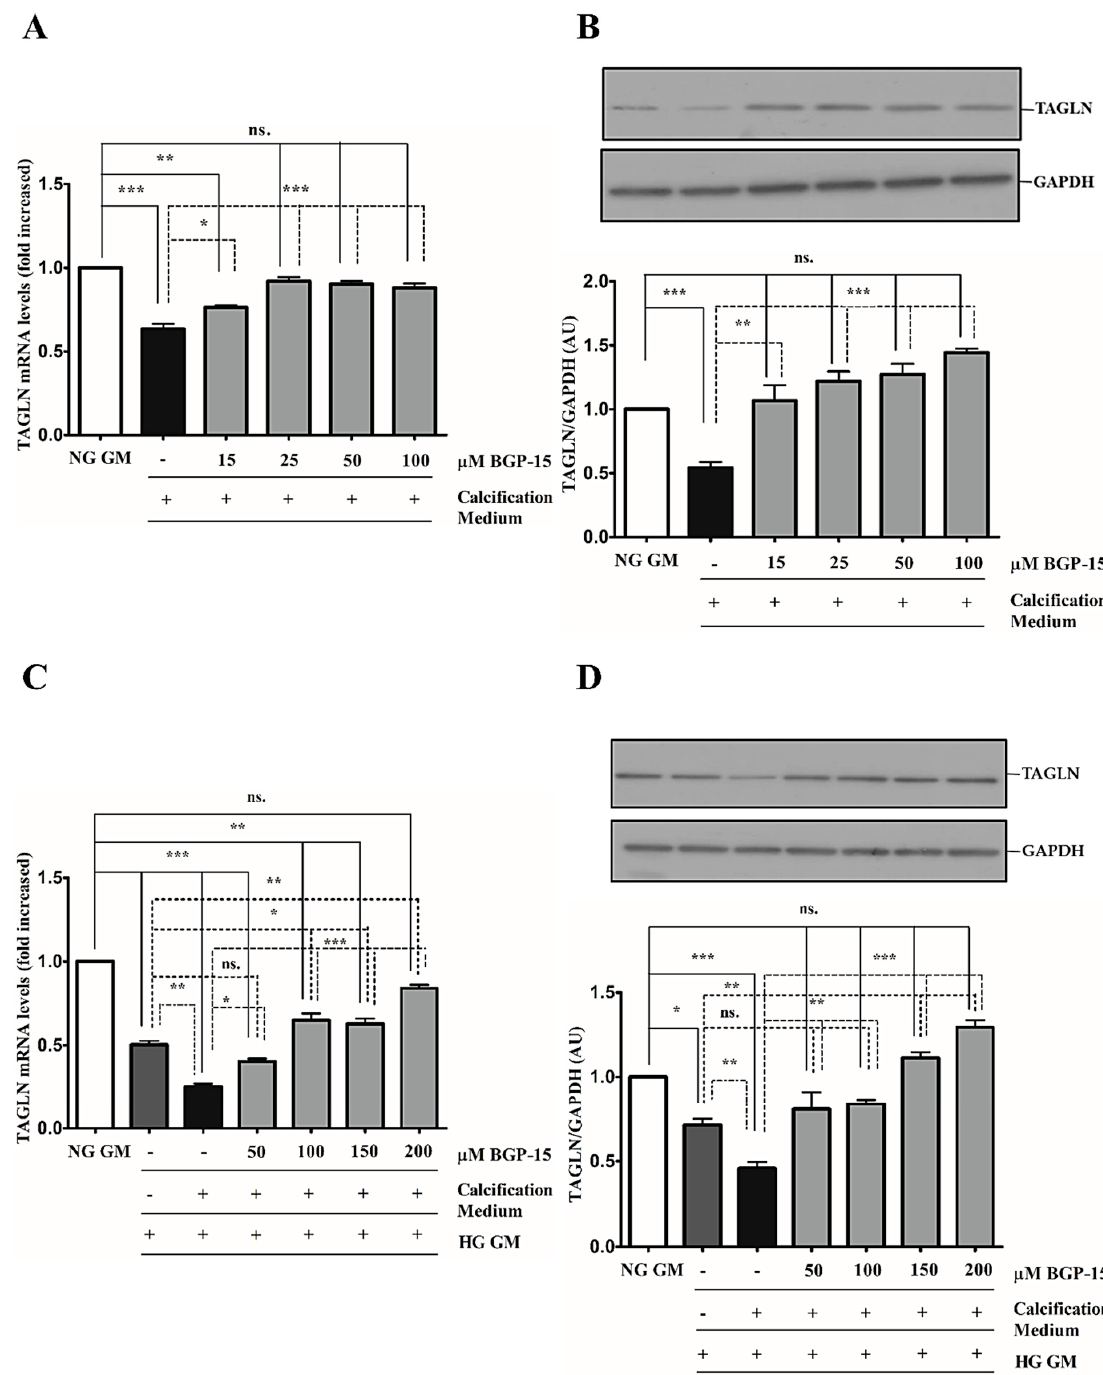
Figure 3. BGP-15 counteracts the loss of TAGLN induced by high Pi in NG and HG conditions. VSMCs were cultured in calcification medium containing 3 mmol/L inorganic Pi under NG (5.5 mM glucose) and HG (11 mM) conditions in the presence or absence of BGP-15 (15–100 µM BGP-15 in NG and 50–200 µM in HG conditions) for 10 days. Expression of TAGLN was analyzed by RT-qPCR and immunoblot (A-D). Relative expression of TAGLN mRNA ( A ) and protein ( B ) in NG and HG (( C ): mRNA, ( D ): protein) is presented as mean ± SEM of three independent experiments. Relative mRNA expression was normalized to RNA45S5, while protein expression to GAPDH. Statistical analysis was performed by the one-way ANOVA test followed by Bonferroni correction. A value of p < 0.05 was considered significant. * p < 0.05, ** p < 0.01, *** p < 0.001.